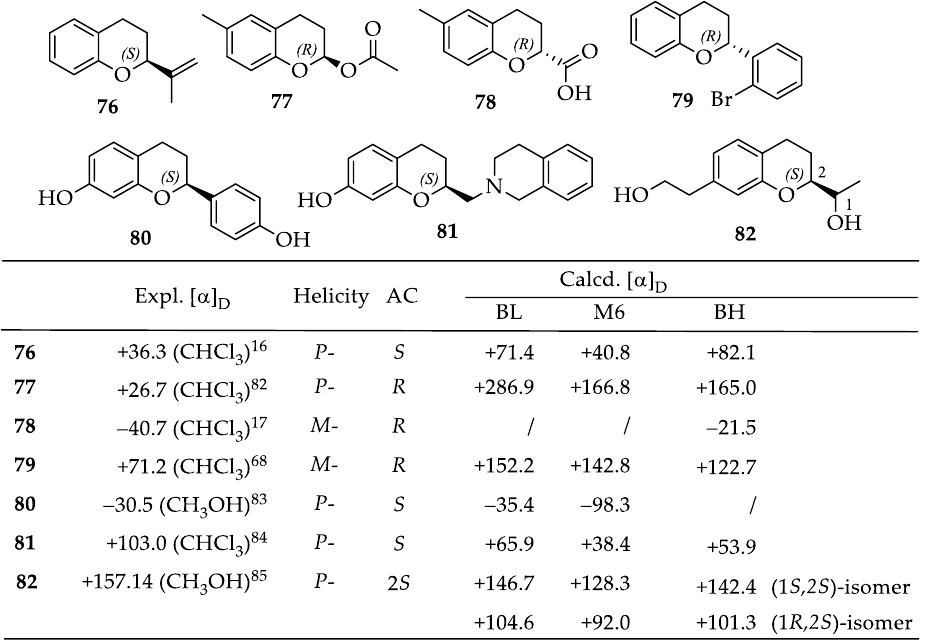
Figure 9. Some chiral 2-substituted chromanes with unidentified configurations. BL: PCM/B3LYP/Aug-cc-pVDZ//B3LYP/6-311G(d,p), M6: PCM/M06-2X/Aug-cc-pVDZ//M06-2X/TZVP, BH: SMD/M06-2X/Aug-cc-pVDZ//BH&HLYP/6-311+G(d,p). Experimental SOR data were